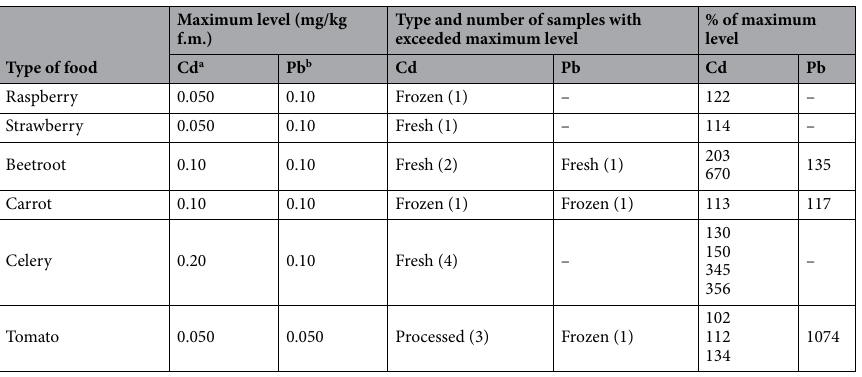
Table 5. The number and type of food samples in which the maximum level of Cd or Pb has been exceeded. a According to Commission Regulation (EU) No 488/2014 of 12 May 2014 amending Regulation (EC) No 1881/2006 as regards maximum levels of cadmium in foodstuffs. b According to Commission Regulation (EU) 2015/1005 of 25 June 2015 amending Regulation (EC) No 1881/2006 as regards maximum levels of lead in certain